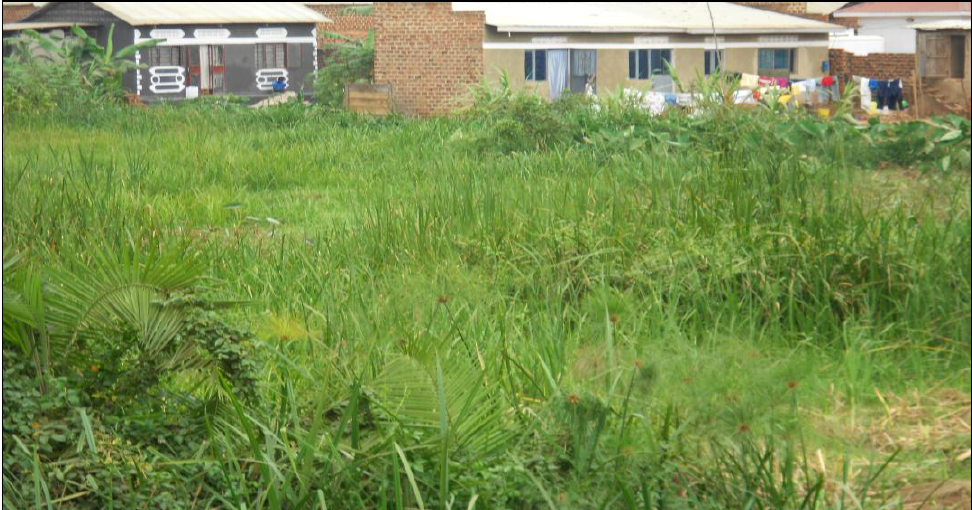
Fig. 6. Houses which have been constructed in a wetland near Kampala, the Capital City of Uganda, in the Central Region, by Alex Barakagira,